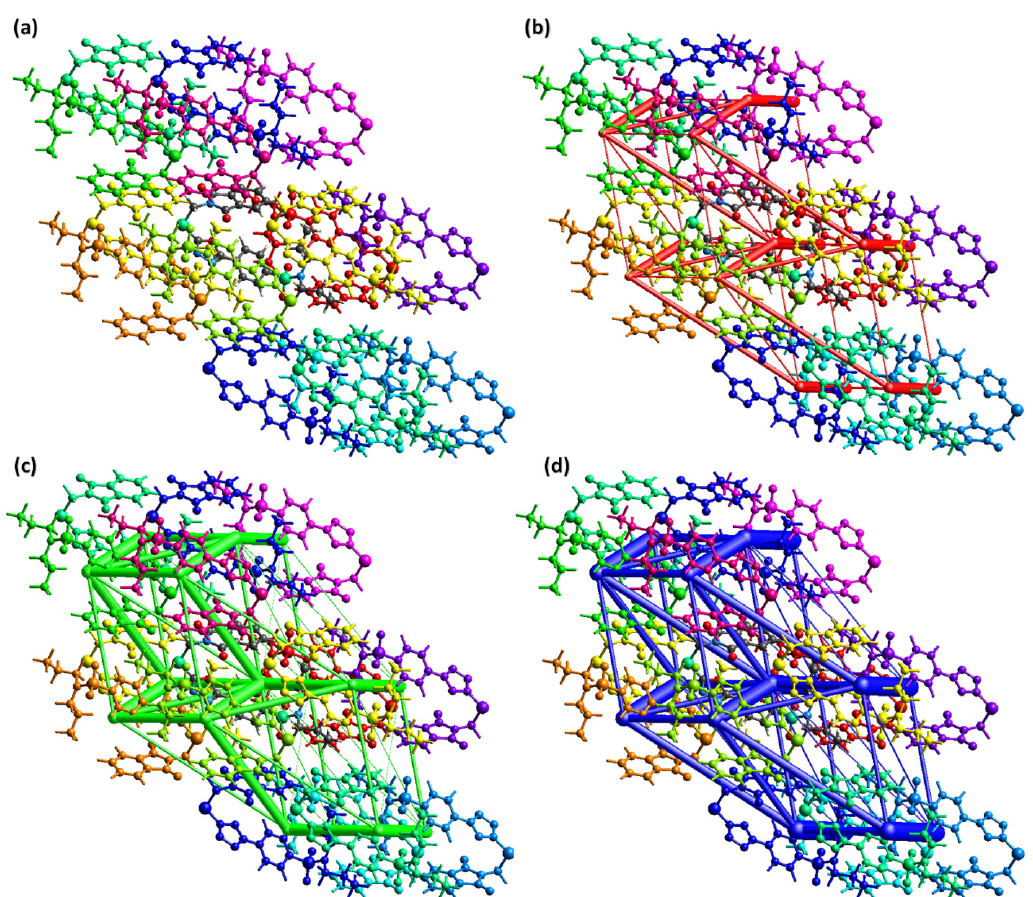
Figure 8. ( a ) Graphical representation of the molecules involved in the computations of the interac- tion energy between molecular pairs. Energy framework for ( b ) coulomb energy, ( c ) dispersion en- ergy, and ( d ) total energy.